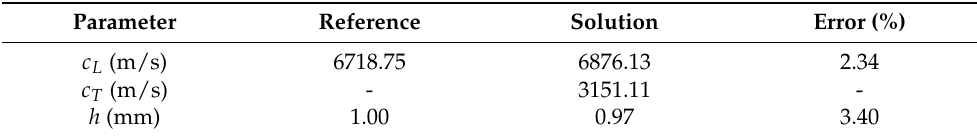
Table 2. Results for experimental